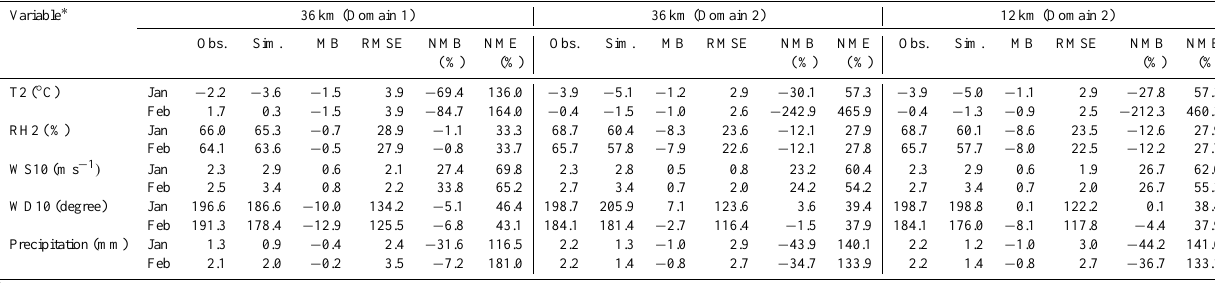
Table 2. Performance statistics for meteorological predictions over Domain 1 at 36km resolution and Domain 2 at 36 and 12km resolutions. Variable ∗